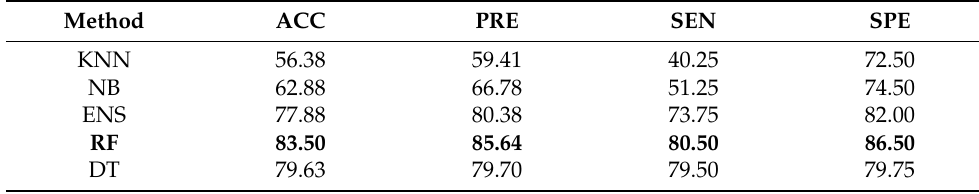
Table A1. AF detection performance based on RQA features.